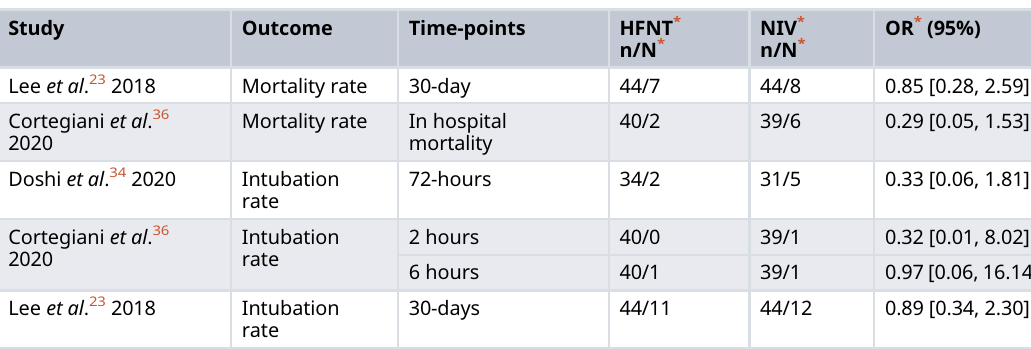
Table 9. Mortality and intubation rate.